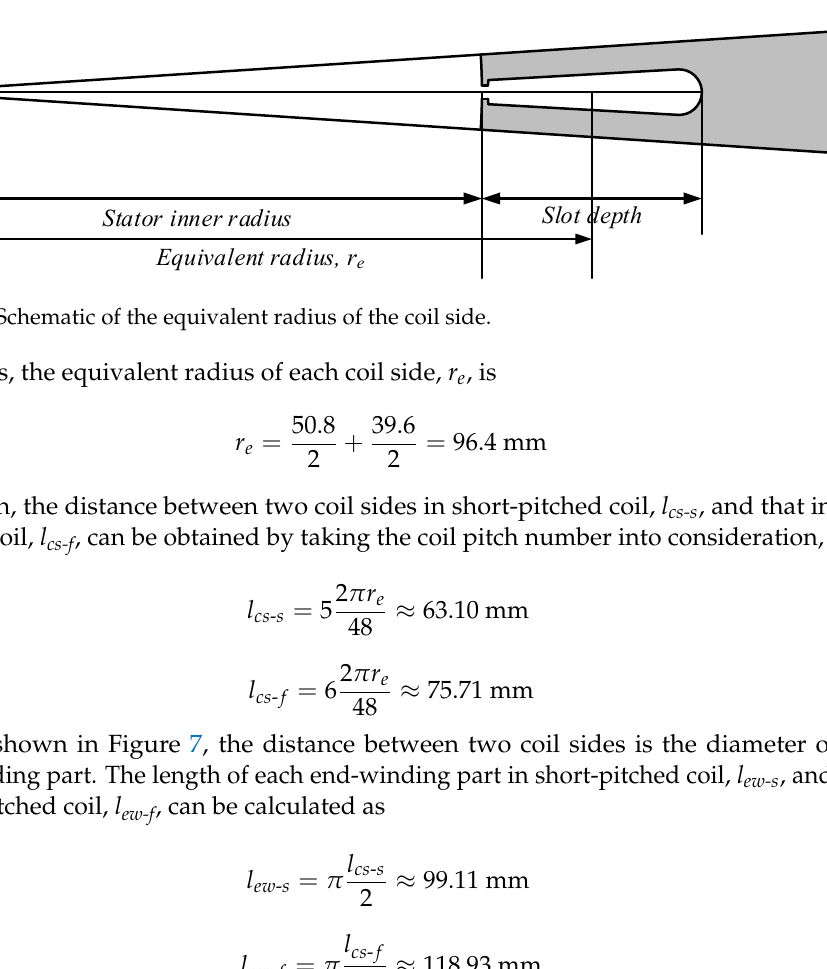
Figure 7. Schemes of different coils: ( a ) short-pitched coil; ( b ) full-pitched coil. It can be seen that both coils can be divided into two parts: the axial winding part and the end-winding part. The length of the axial winding part is the stator’s axial length. The length of the end-winding part can be calculated based on the stator’s inner diameter, slot depth, and coil pitch number, and these data be found in Table 1. Since all coil sides are assumed to be at the center of slots, the equivalent radius of each coil side, r e , is the sum of the stator’s inner radius and a half of the slot depth, as shown in Figure 8.